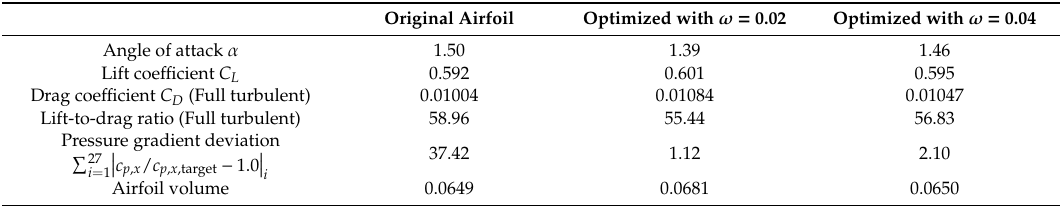
Table 3. Aerodynamic performance of the airfoils ( Ma = 0.73, Re = 6.5 × 10 6